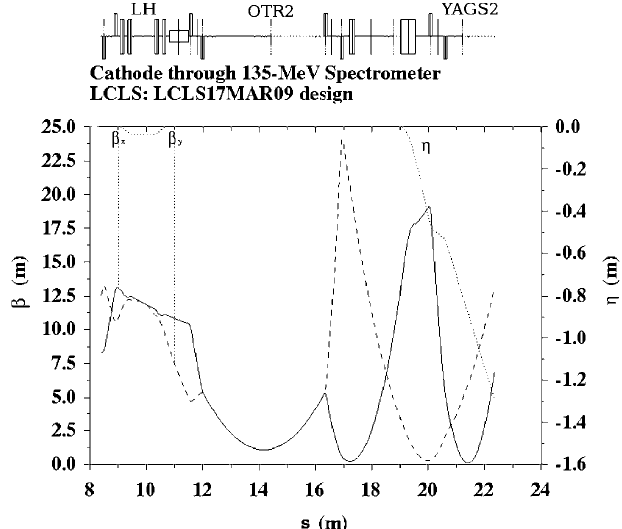
FIG. 12. Designed beta and dispersion functions from the laser heater to 135-MeV spectrometer in the LCLS injector.